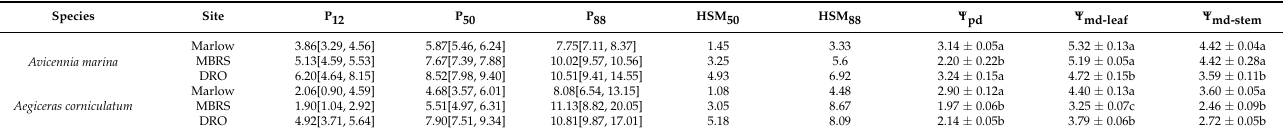
Table 2. Xylem embolism resistance (P 12 , P 50 , P 88 ; − MPa); hydraulic safety margin (HSM 50 , HSM 88 ; MPa); Ψ pd , predawn water potential ( − MPa); Ψ md-leaf , midday leaf water potential ( − MPa); Ψ md-stem , midday stem water potential ( − MPa) of the two mangrove species in the three sample sites. Water potential values are shown as mean ± standard error (SE, n = 5).